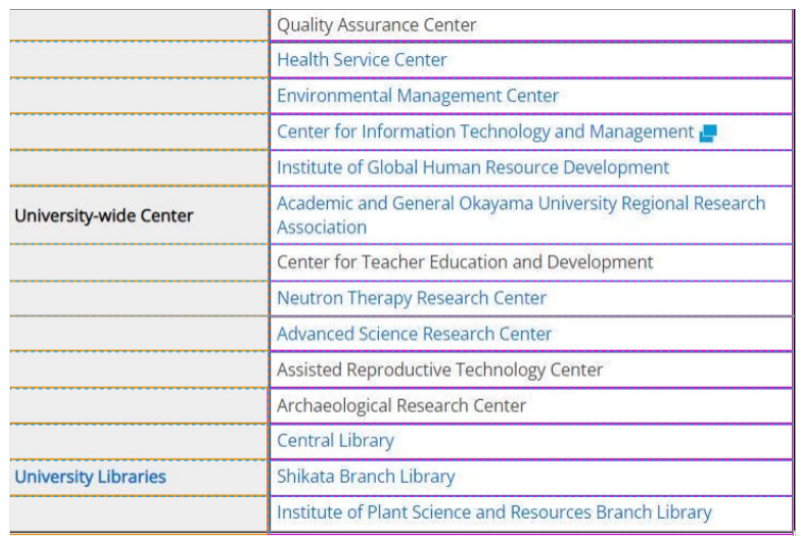
Figure 32. Result with too many dotted lines.